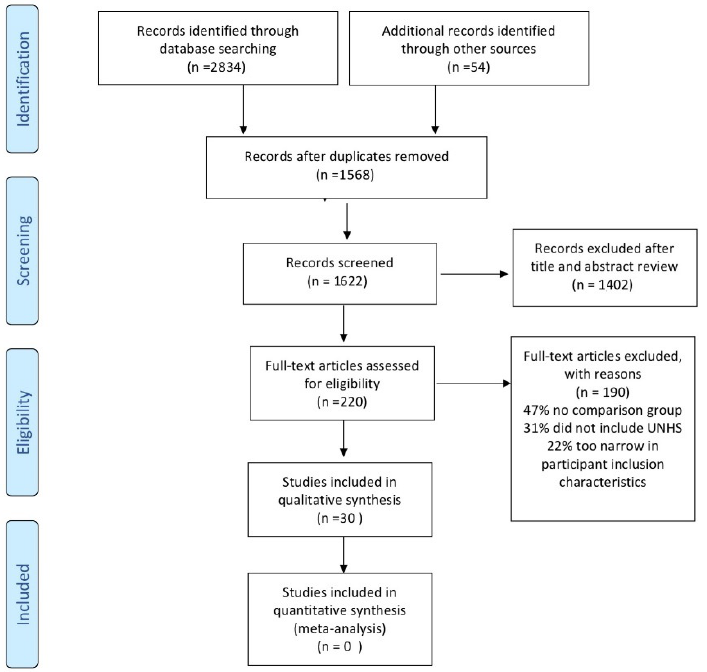
Figure 1. PRISMA systematic review flow diagram.